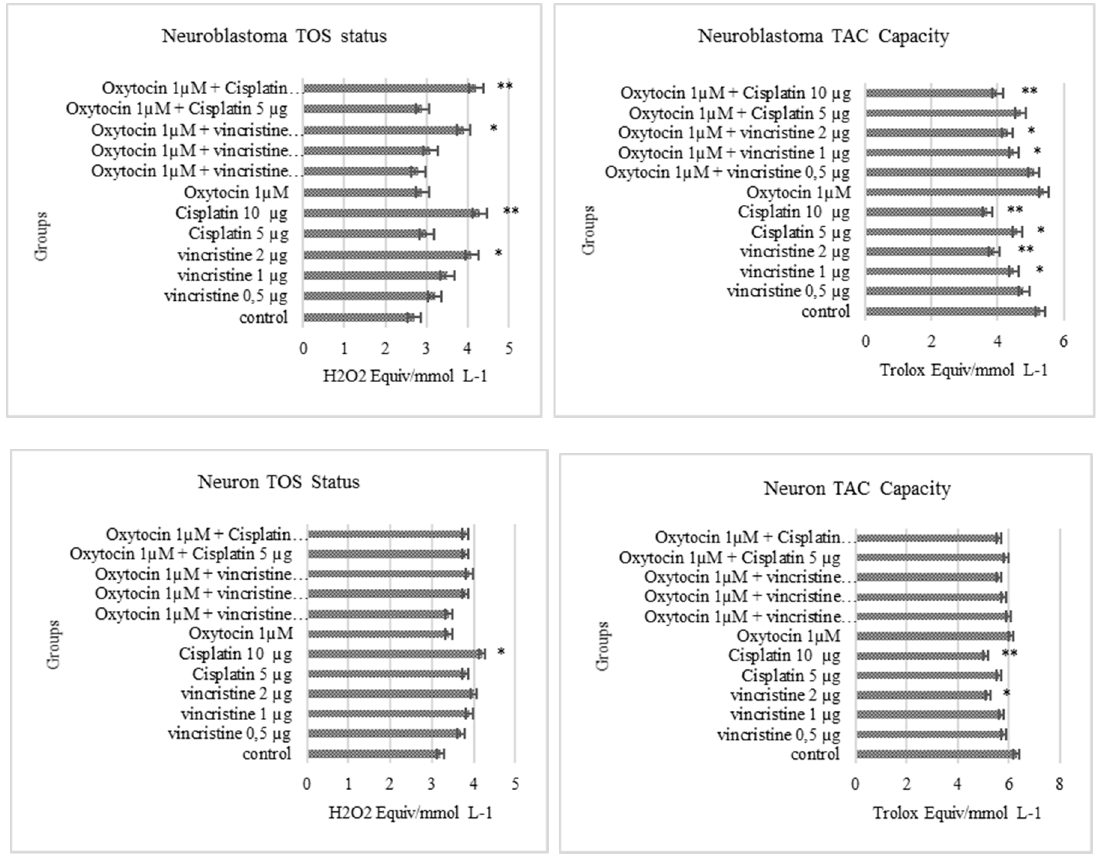
Figure 2. TAC and TOS results of chemotherapeutics and oxytocin combination on neuroblastoma and primary cortical neuron cells ( n = 6/group) were shown. * Significant differences at p < 0.05 compared to control group; ** Significant differences at the p < 0.001 compared to control